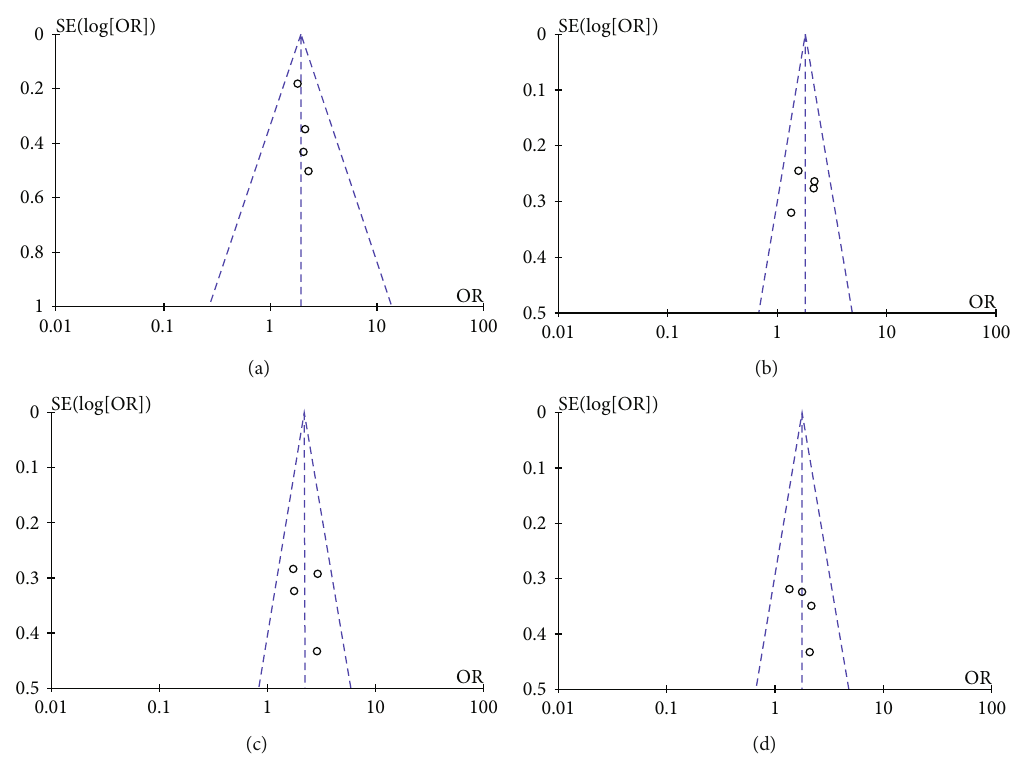
Figure 7: (a) The funnel plot identifying the biased literature publication. (b) The funnel plot identifying the biased literature publication. (c) The funnel plot identifying the biased literature publication. (d) The Funnel plot identifying the biased literature